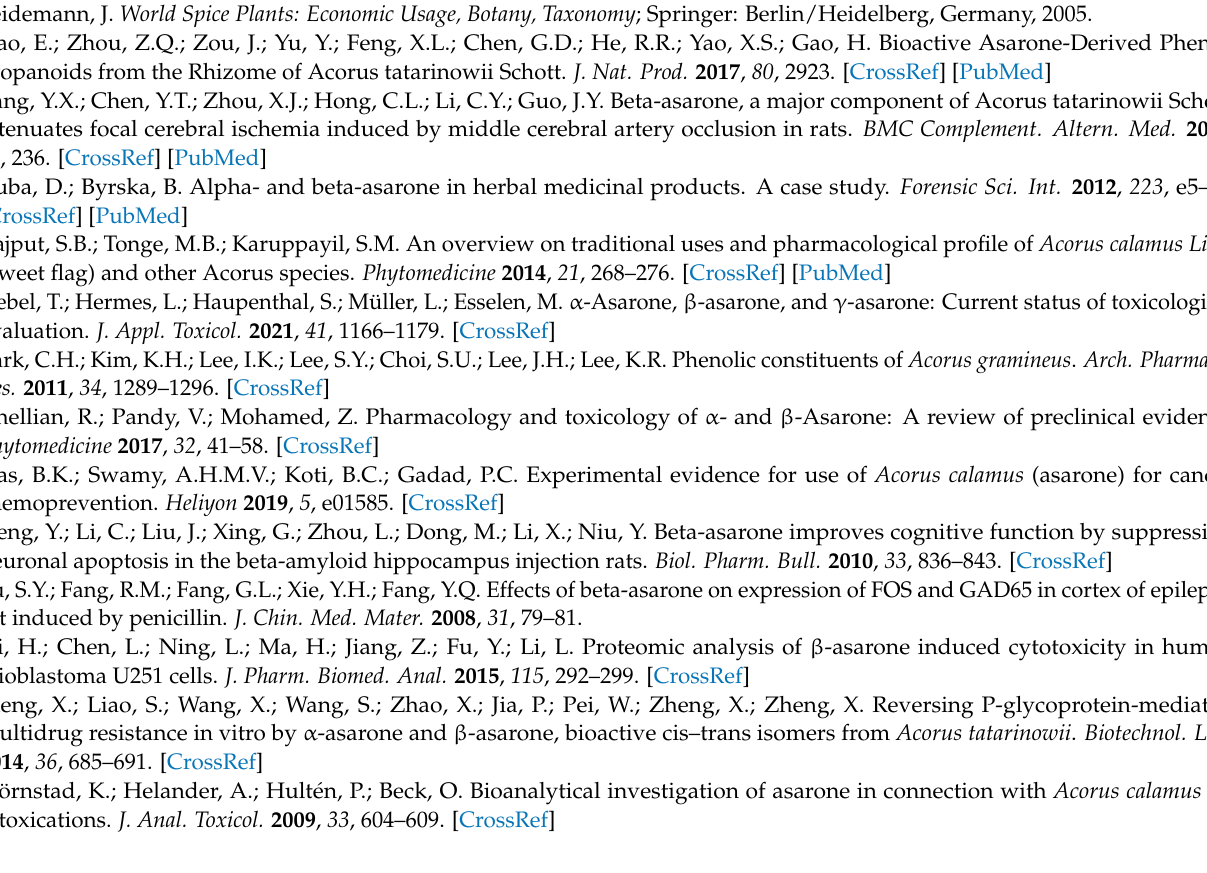
asarone; Figure S2: COSY Spectrum of β -asarone; Figure S3: DEPT-135 Spectrum of β -asarone; Figure S4: HSQC Spectrum of β -asarone; Figure S5: HMBC Spectrum of β